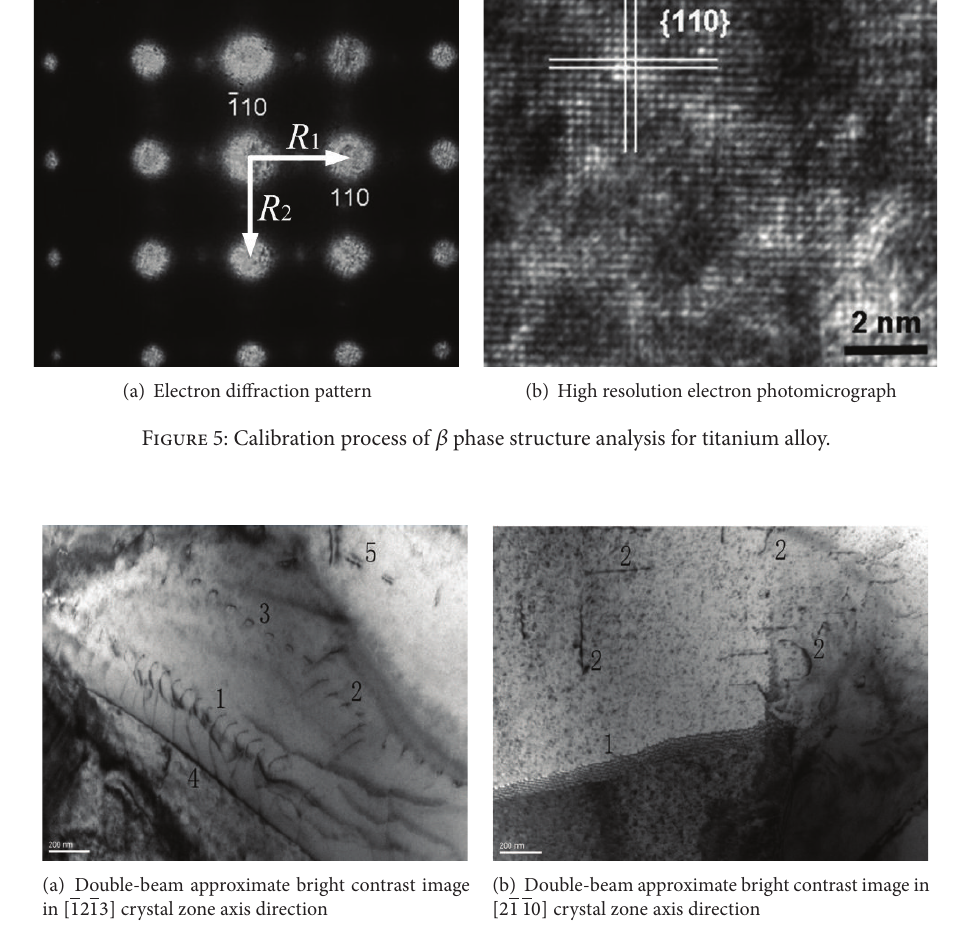
Figure 6: Double-beam approximate bright contrast images of 𝛼